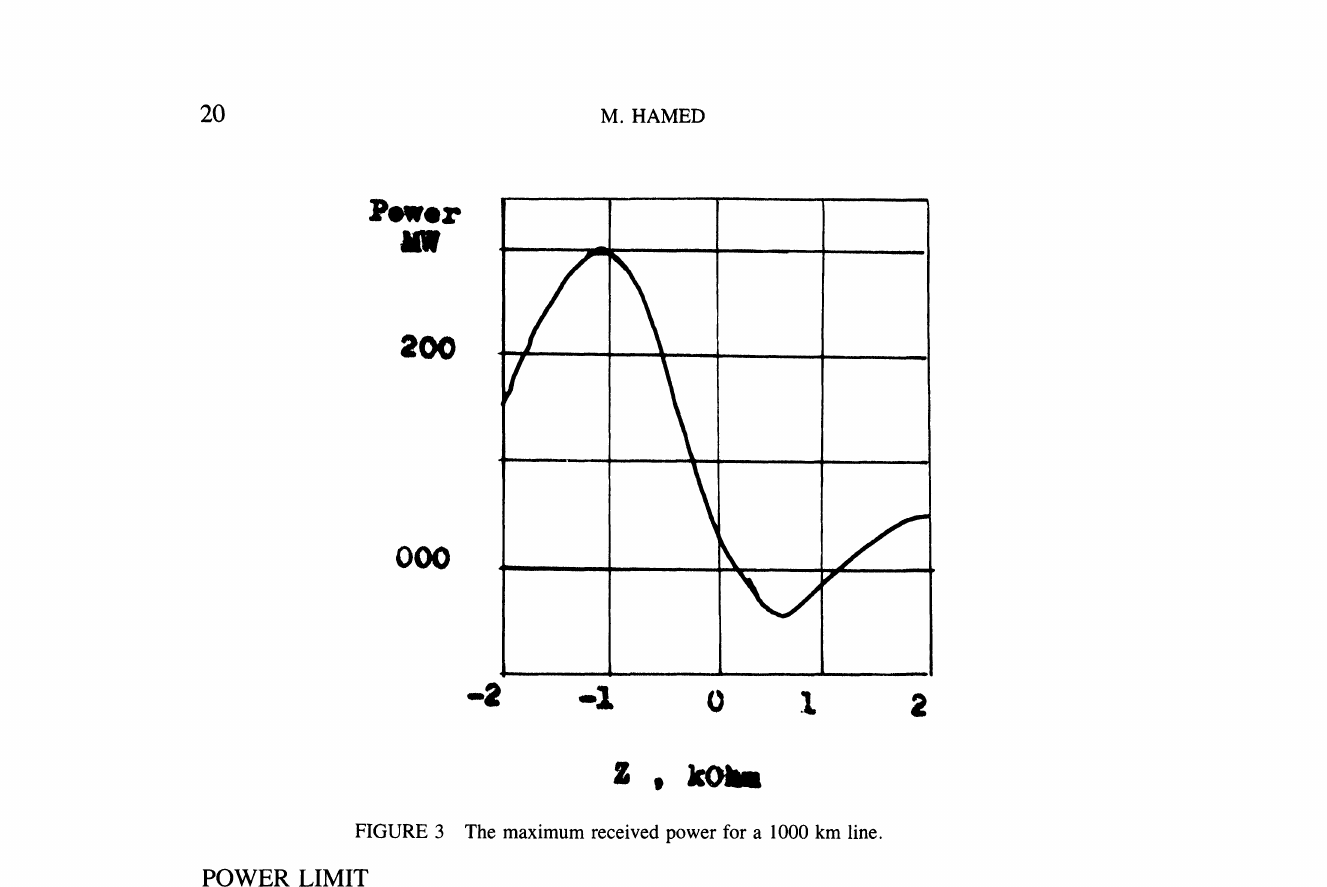
FIGURE 3 The maximum received power for a 1000 km